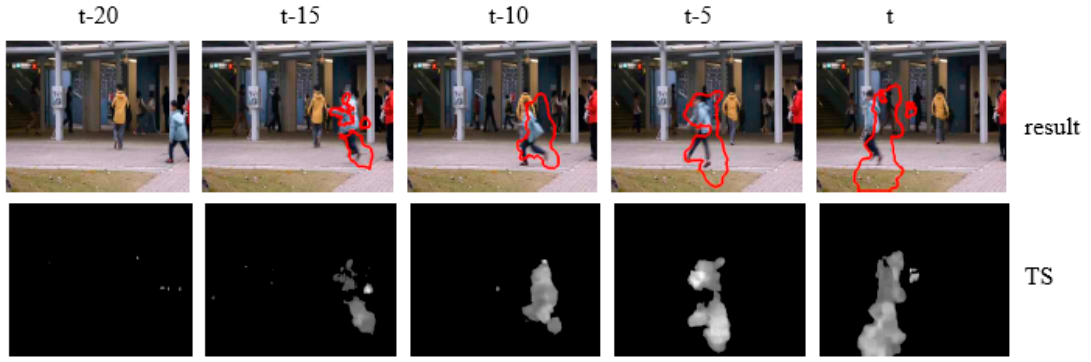
12 of 18 Figure 10. Examples of detection results for abnormality from No. 3 data (UMN Scene 3: Plaza). For the Avenue dataset, the methods described in [21], [26], and [29] were compared with the proposed method. The Avenue dataset contatins 16 training videos and 21 testing videos. The only normal behavior in the dataset is people walking in front of the camera, and the abnormal behaviors are unusual actions such as running and jumping, and walking in the wrong direction. Table 3 demonstrates the AUC(area under the curve) values of both the proposed method and the state-of- the-art comparison methods [21,26,29] for the Avenue dataset. The method in [26] was previously tested on the whole Avenue dataset, and the provided results were used in the comparison. The comparison results of Table 4 shows that the performance of the proposed method outperforms the comparison methods. Due to the unpredictability of abnormal events, most previous approaches employ a learning process, and most of them only learn normal event models in an unsupervised or semi-supervised manner, and abnormal events are considered to be patterns that significantly deviate from the created normal event models [29]. The method used in [21] uses spatio–temporal convolutional neural networks to extract and learn various features, and the method in [29] employs the online dictionary